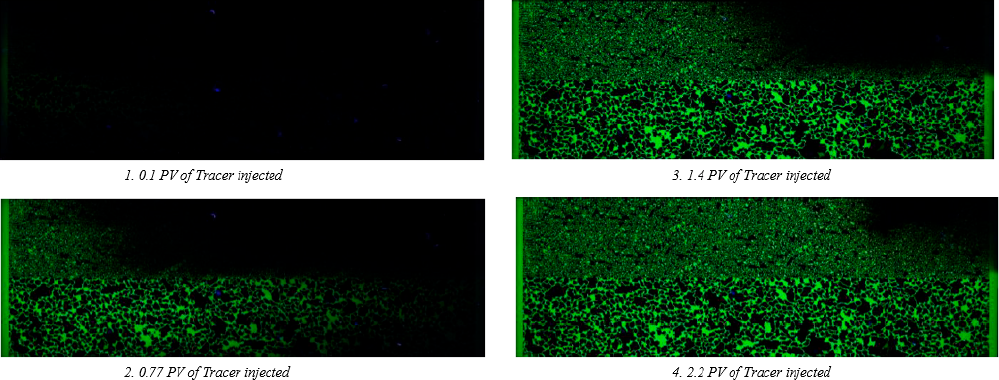
Figure 5. Visual tracer injection into 100% brine saturated heterogenous micromodel.